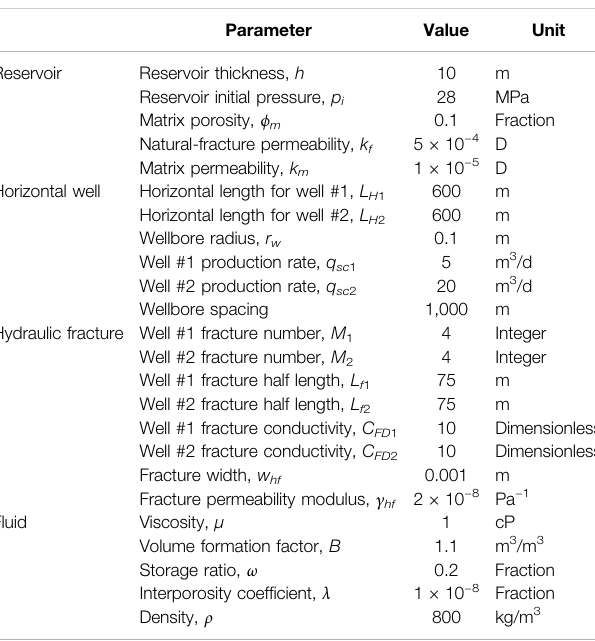
TABLE 1 | Physical properties of a multi-well pad with multiple fractures used in the commercial reservoir